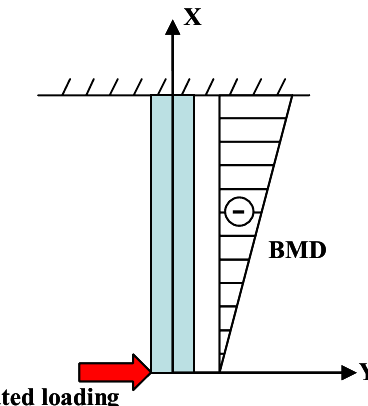
Fig. 6 A bending moment diagram of a cantilever subjected to concentrated loading. The bending moment increases linearly as it nears the rigid